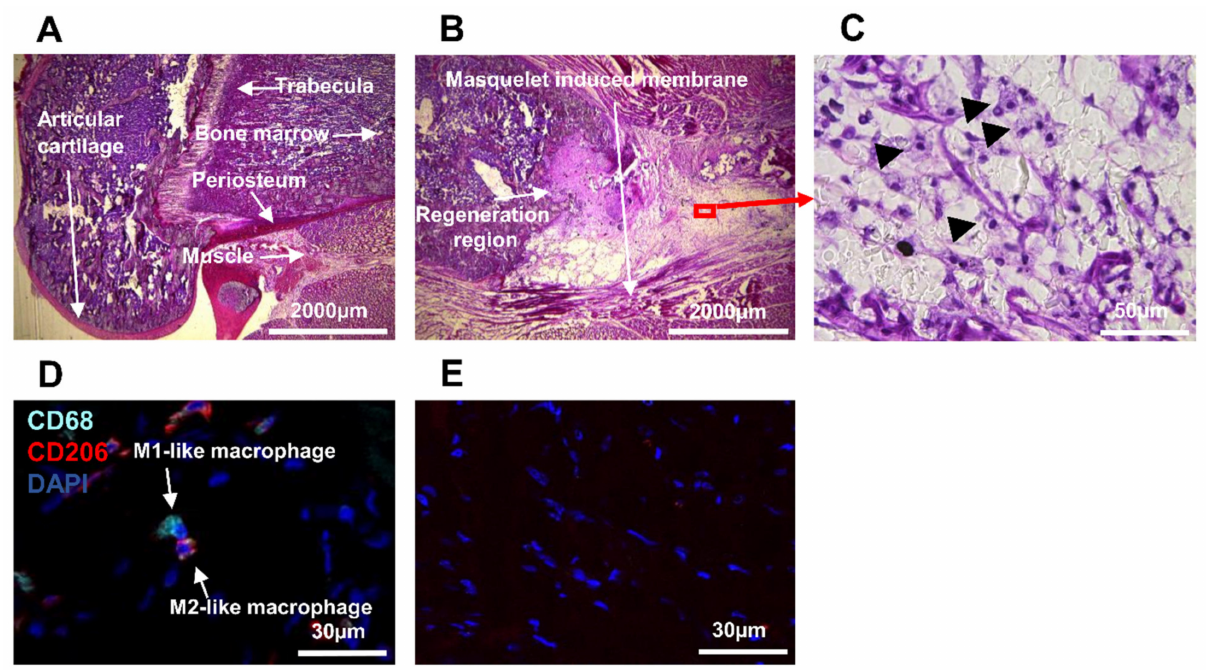
Figure 2. Histologic and microscopic analysis of rat femur: ( A – C ) histologic analysis of the fe- murs; histopathological image of ( A ) non-operated; and ( B ) operated femurs of rats stained with hematoxylin and phloxin; ( C ) expanded view: high magnification image of the area within the red rectangle in image ( B ); ( D , E ) identification of macrophages M1 and M2 in the operated femur; anti-CD68 (Alexa488, turquoise fluorescence), labeling the M1 and M2 macrophages; anti-CD206 (Alexa568, red fluorescence) labeling the M2 macrophages and satellite cells; nuclear staining with DAPI (blue